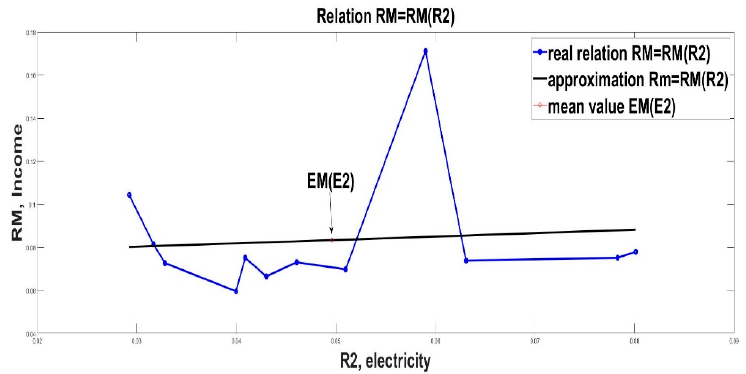
Figure 4. Linear approximation of income R M from R 3 (salaries).